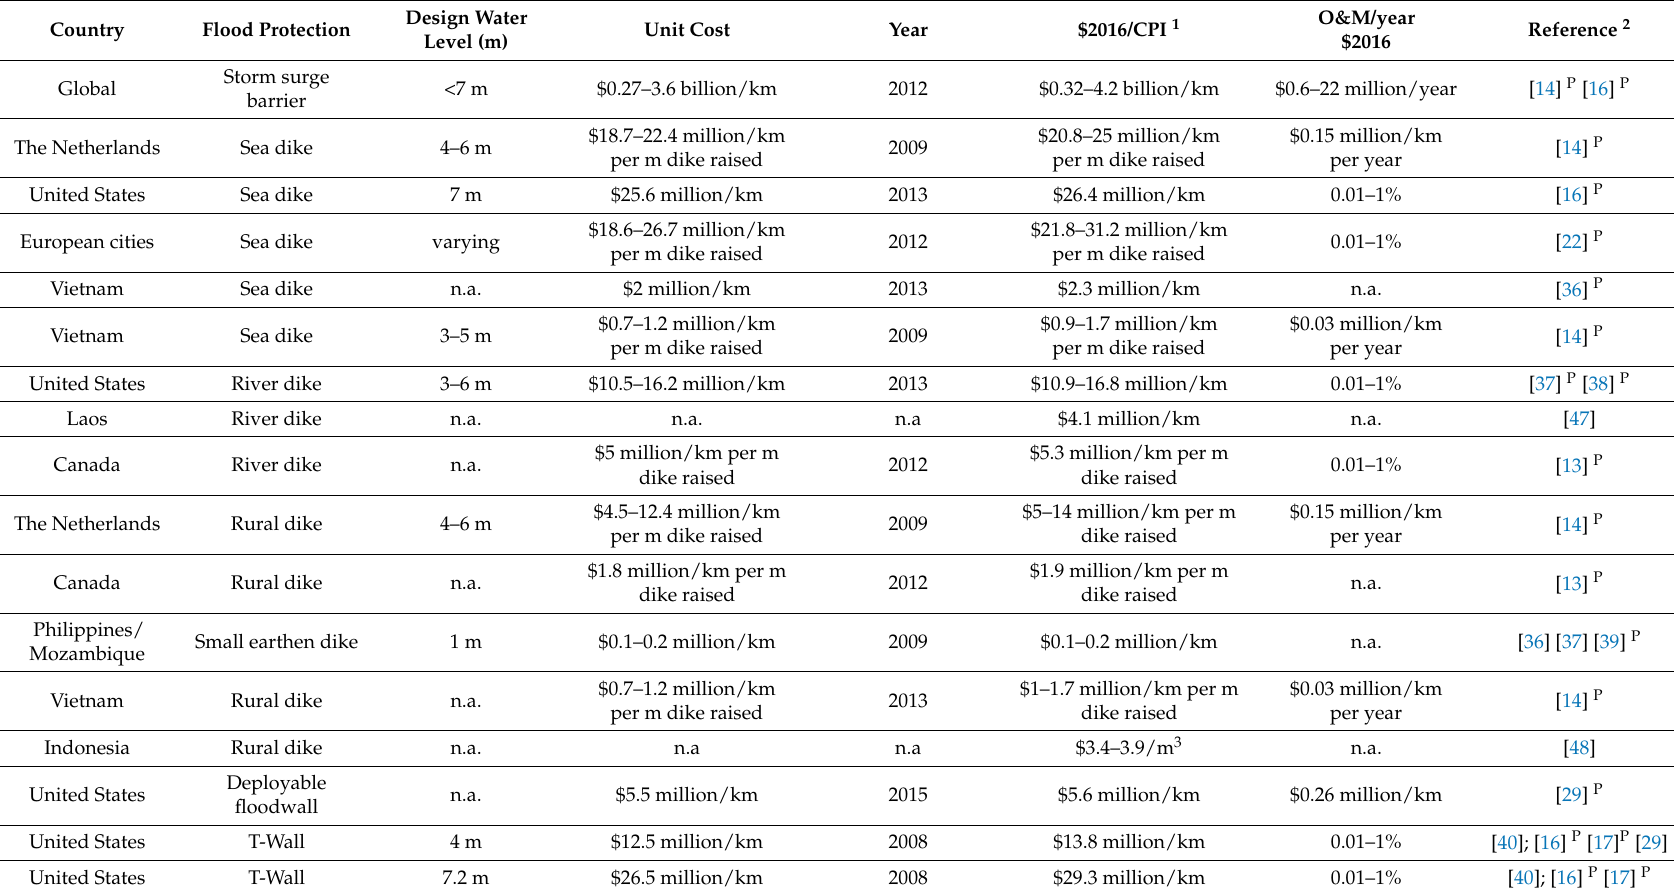
Table 4. Types of flood-protection measures, investment costs, and maintenance